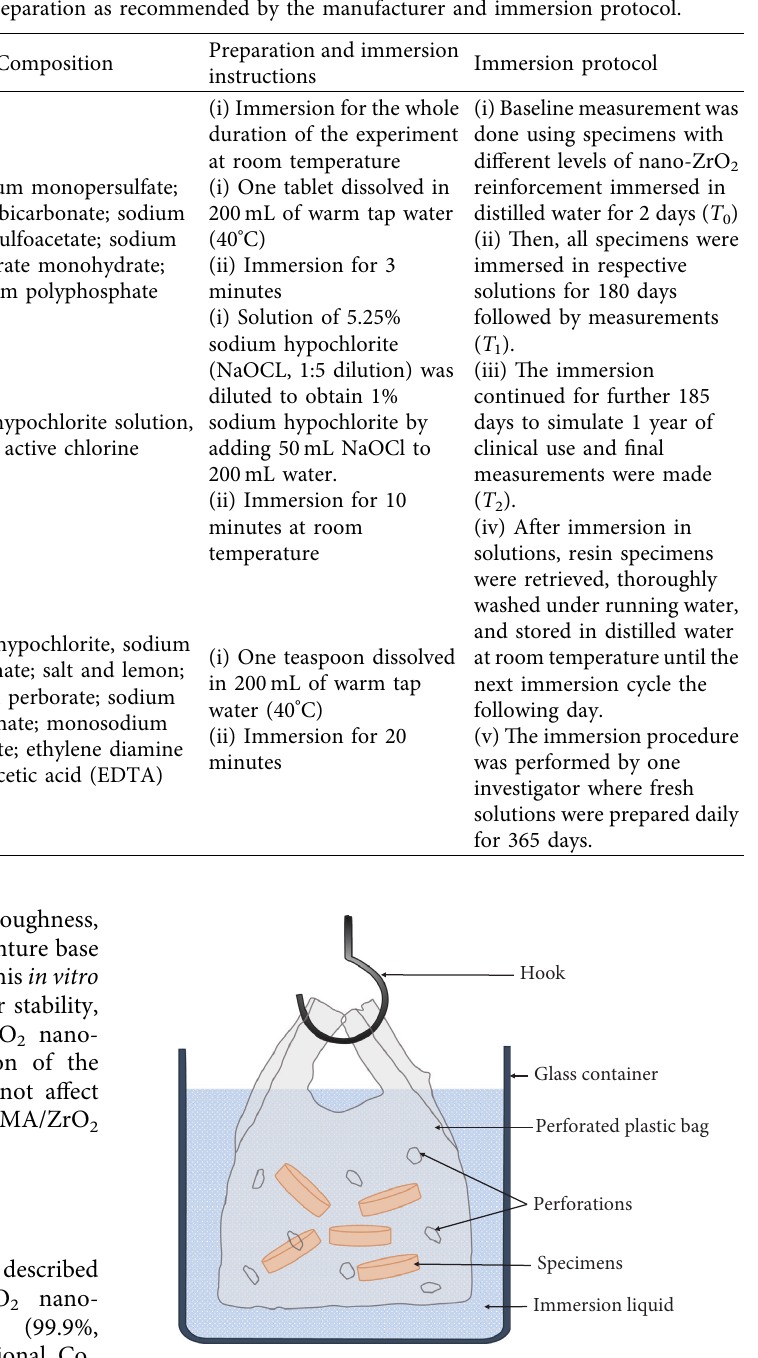
Figure 2: Illustrated diagram for specimen immersion in denture